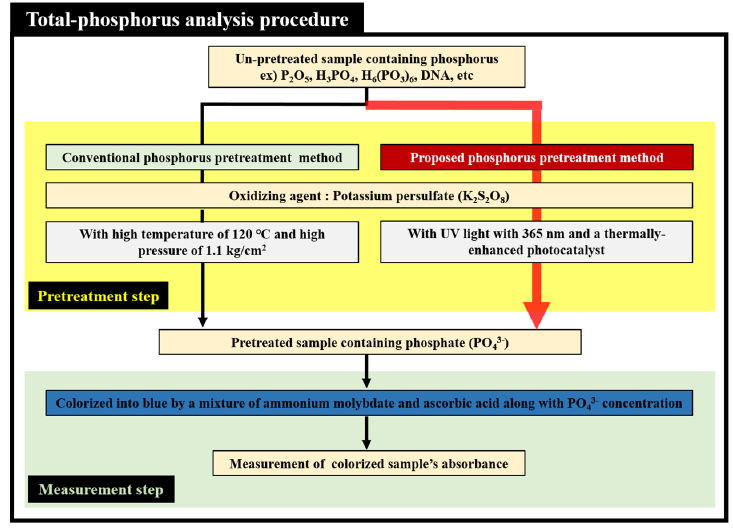
Figure 1. Principle of total-phosphorus (TP) analysis procedure employing thermally enhanced photocatalytic reaction.